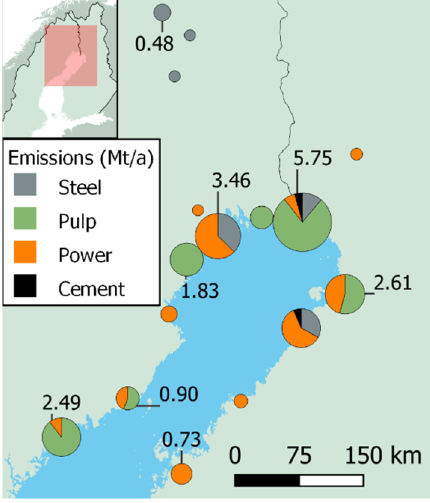
Figure 2. Distribution of the largest emitters of CO 2 from the region (data from [35]).